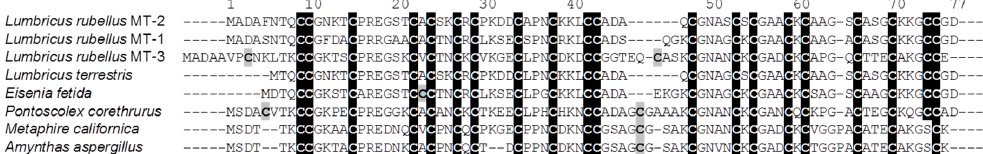
Figure 1. Sequence alignment of selected annelid MTs, showing conservation of two blocks of Cys-rich regions with 11–12 and 8–9 Cys residues (highlighted by black boxes). All three sequences from L. rubellus are shown; the numbering refers to wMT-2. Non-conserved Cys residues are highlighted in grey.